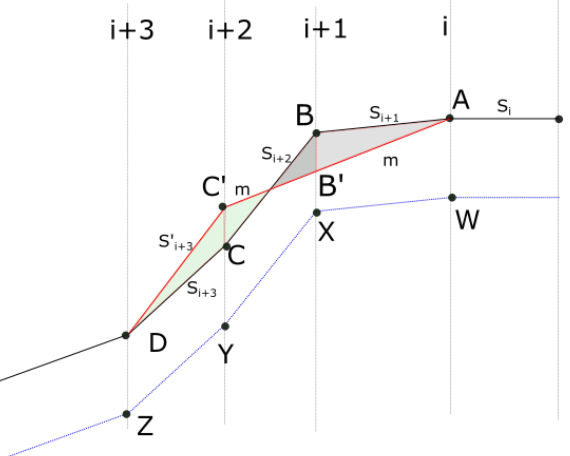
Figure A1. Numerical schematisation of slumping based on critical slope and fall by gravity only. The line ABCD is the profile line which had WXYZ permafrost line at various thawing depths of each grid point. The slope at point B is greater than m a which triggers the slumping and the new position for the point B at the same grid line is B (cid:48)